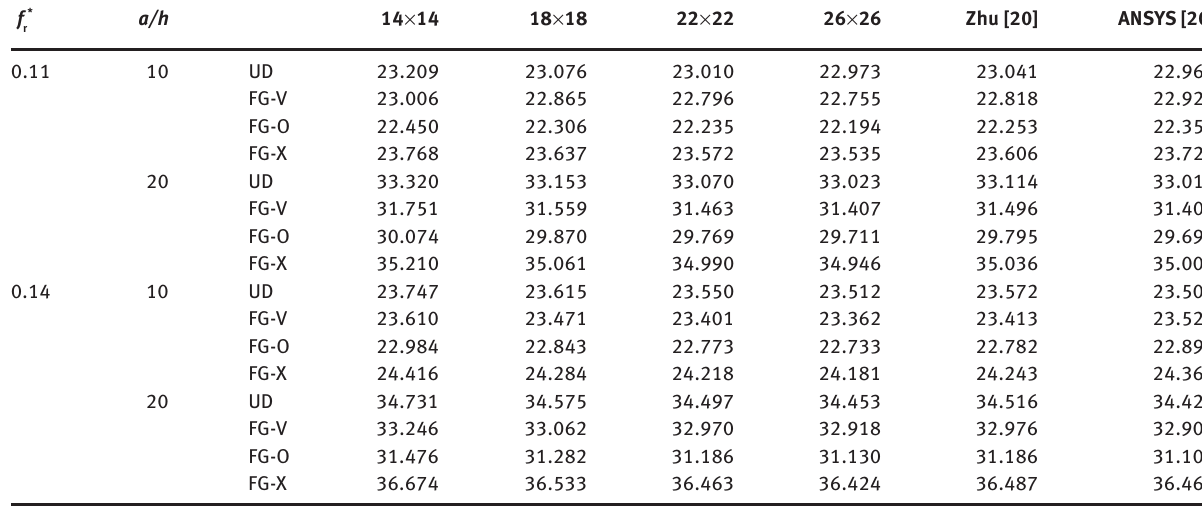
Table 7 Convergence and accuracy of the second dimensionless natural